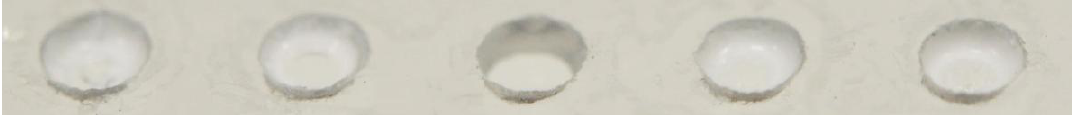
Figure 3. Microchip made of 500 μm thick borosilicate glass with holes of 1.2 mm diameter. Four holes were filled.